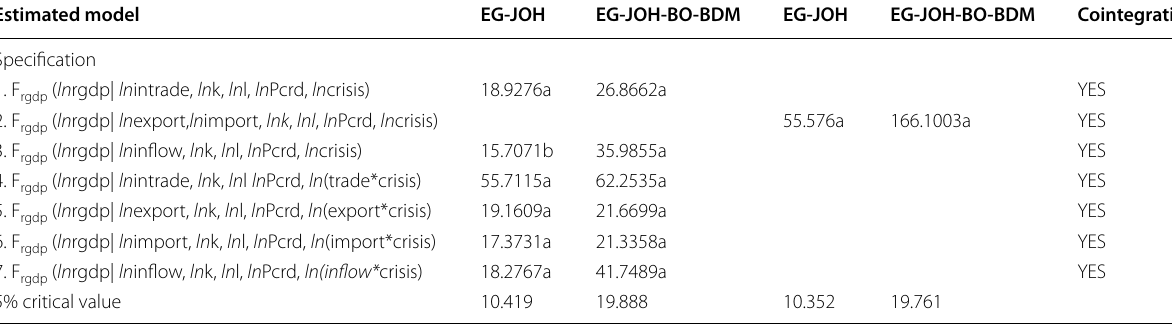
Table 3 Bayer and Hanck [10] cointegration Estimated model